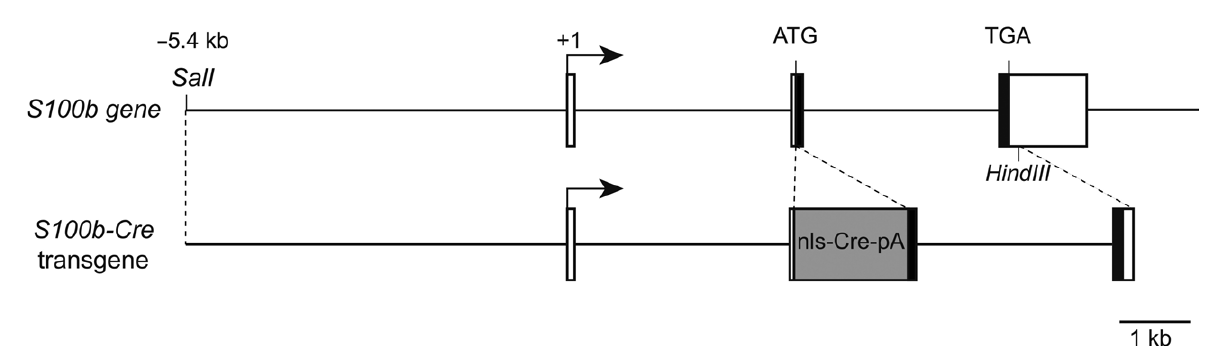
Figure 1. Structure of the mouse S100b gene and S100b-Cre transgenic construct. Boxed regions represent exons I-III of the mouse S100b gene. The black part indicates the protein coding region. The transgene consists of the − 5.4 kb to + 6.3 kb S100b genomic sequence with insertion of a cDNA encoding Cre recombinase with nuclear localization and poly-A signals